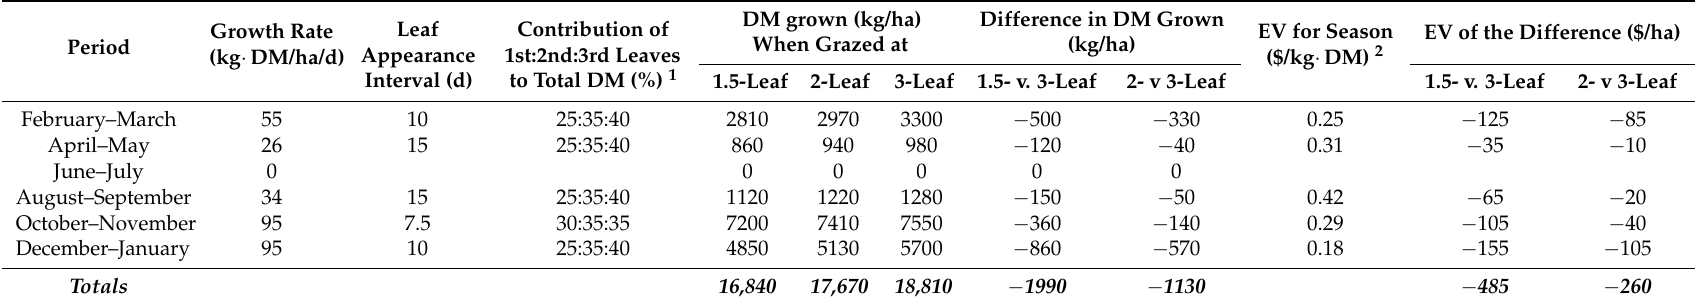
Table 2. Estimated difference in dry matter grown and economic value (EV) of pasture for a dairy farm in Canterbury, New Zealand, where grazing occurs consistently at the 1.5 or 2-leaf stage of regrowth compared with the 3-leaf stage of regrowth.